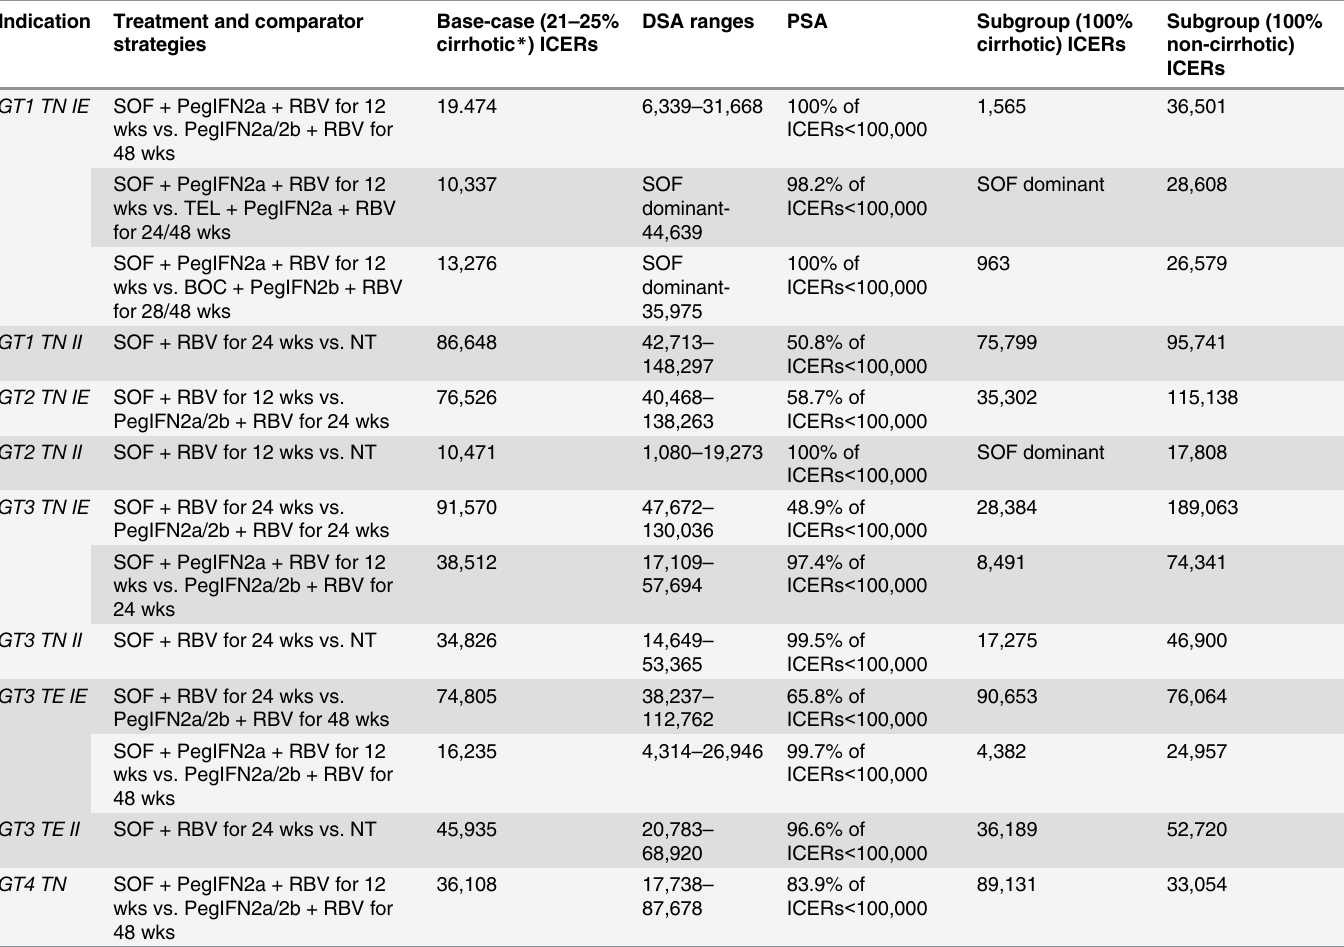
Table 4. Summary of base-case, sensitivity and subgroup analysis